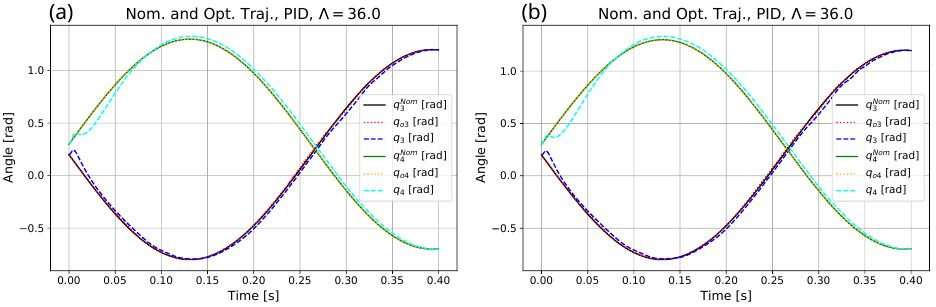
Figure 3. Trajectory tracking without force limitation for q 1 and q 2 : ( a ) For the set 1. ( b ) For the set 2.